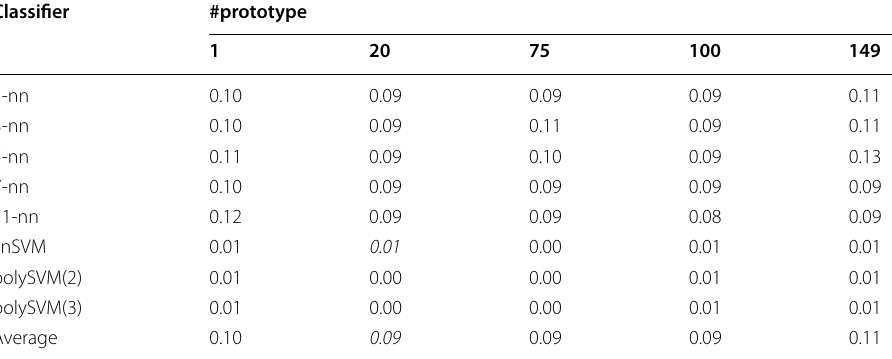
Table 4 Evaluation of proposed method on Iris dataset in terms of runtime